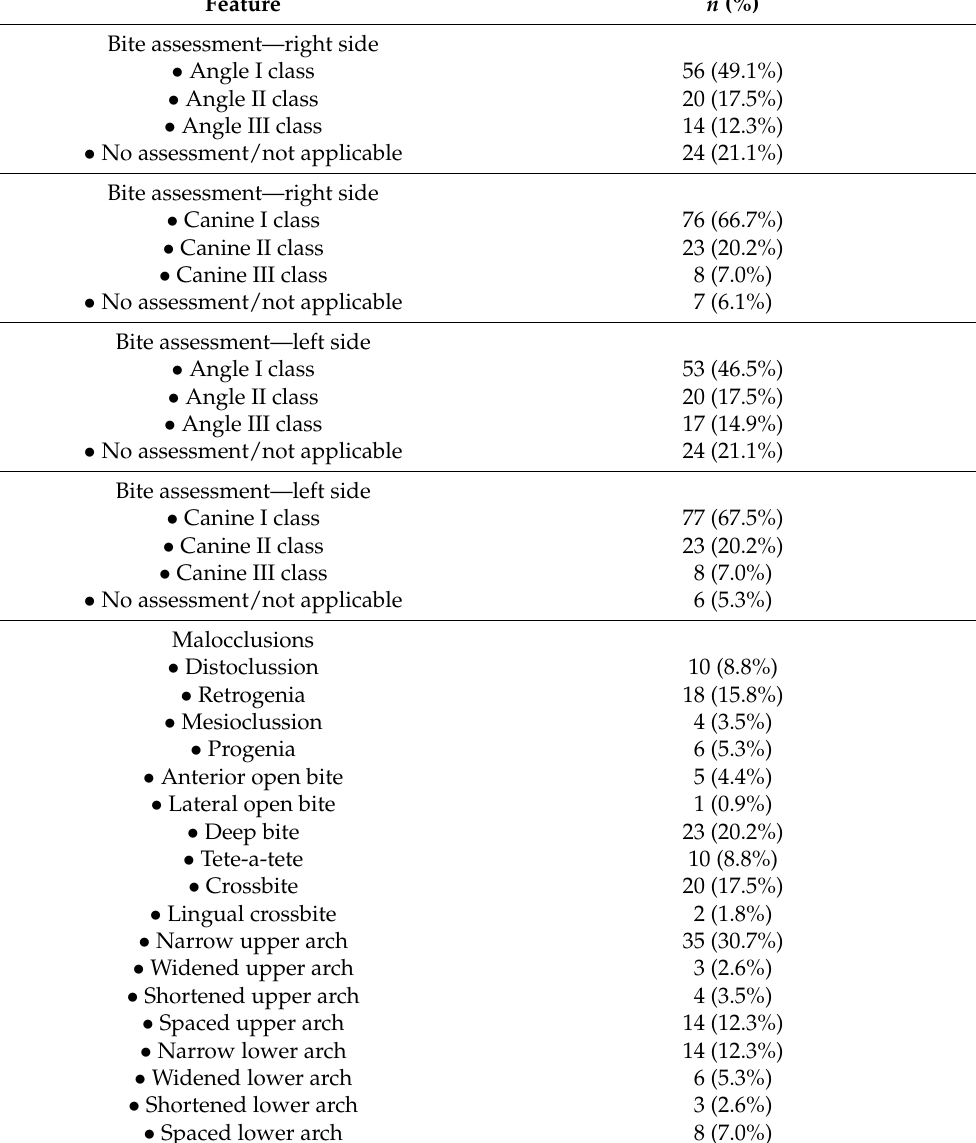
Table 1. Skeletal and dentoalveolar features; n , number of patients.